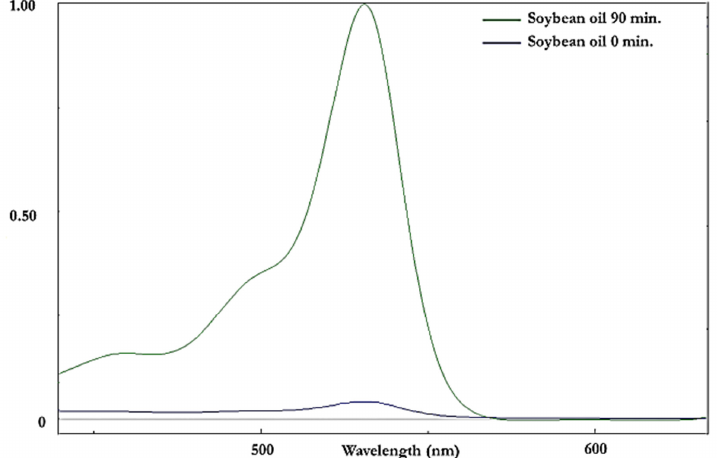
Figure 6. Visible (440–640 nm) region electronic absorption spectra of an aqueous extract of soybean oil derivatised with the TBA reagent both before (mauve spectrum) and after (green spectrum) exposure to a LSSFE at a temperature of 180 °C for 90 min. The first extraction efficacy of the method employed for interference-free, specific MDA determination [19] was 78 ± 2% (mean ± SEM). The absorbance values at 532 nm correspond to CFO MDA concentrations of 1.5 and 31 µmol.kg − 1 oil for the 0 and 90 min. LSSFE time-points, respectively.